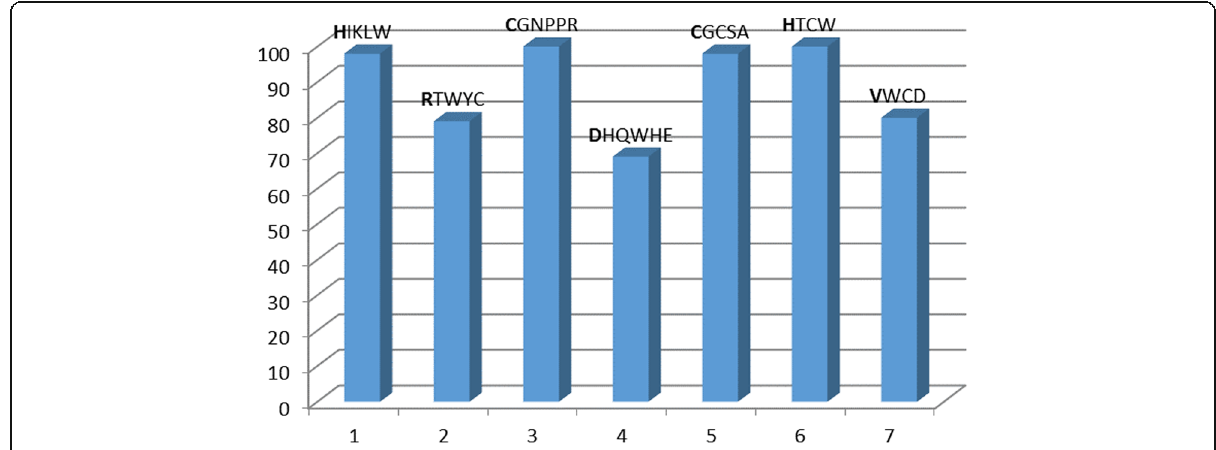
Fig. 5 Rules extracted for the PSSP model using the location of the β -helix